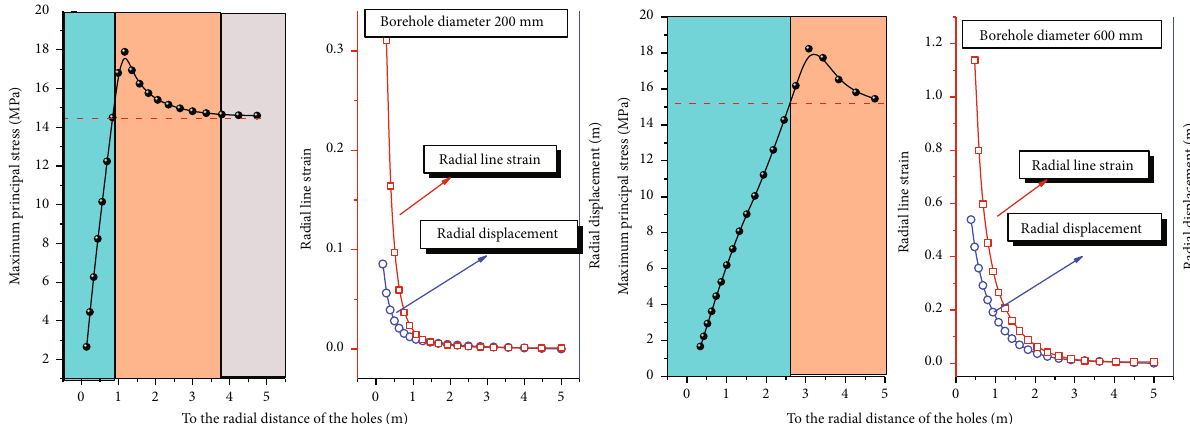
Figure 7: Distribution curve of the maximum principal stress, radial displacement, and radial line strain of coal around the boreholes.